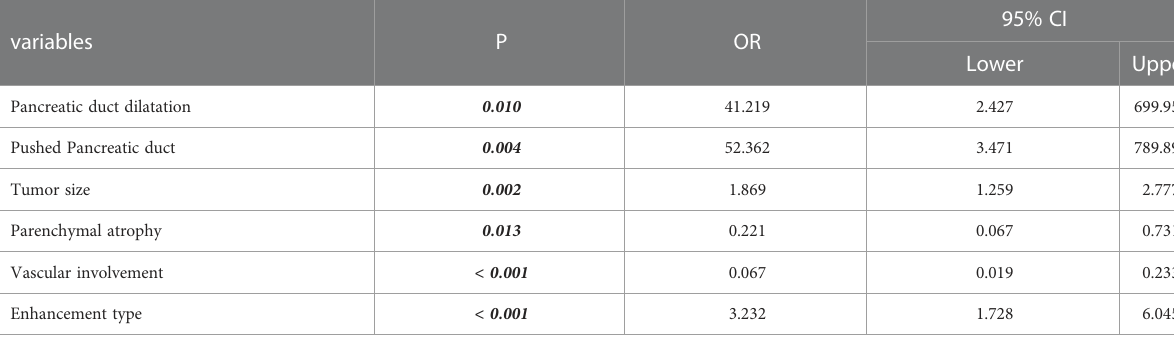
TABLE 4 Six radiological features for PM-SCLC diagnosis in multivariate logistic regression analysis.